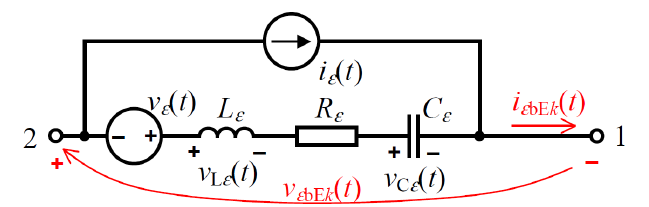
Figure 3. The generalized linear branch of the electric